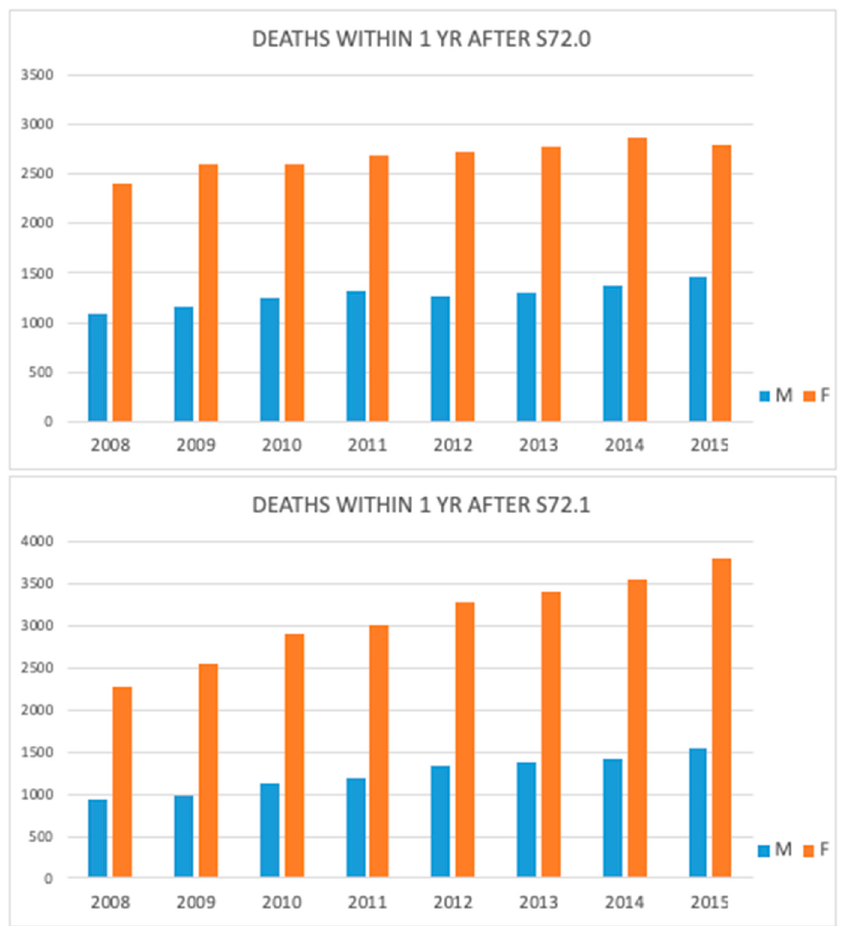
Figure 9. Number of deaths within one year after femoral neck (S72.0) and pertrochanteric fracture (S72.1) during the study period. J. Clin. Med. 2019 , 8 , x FOR PEER REVIEW